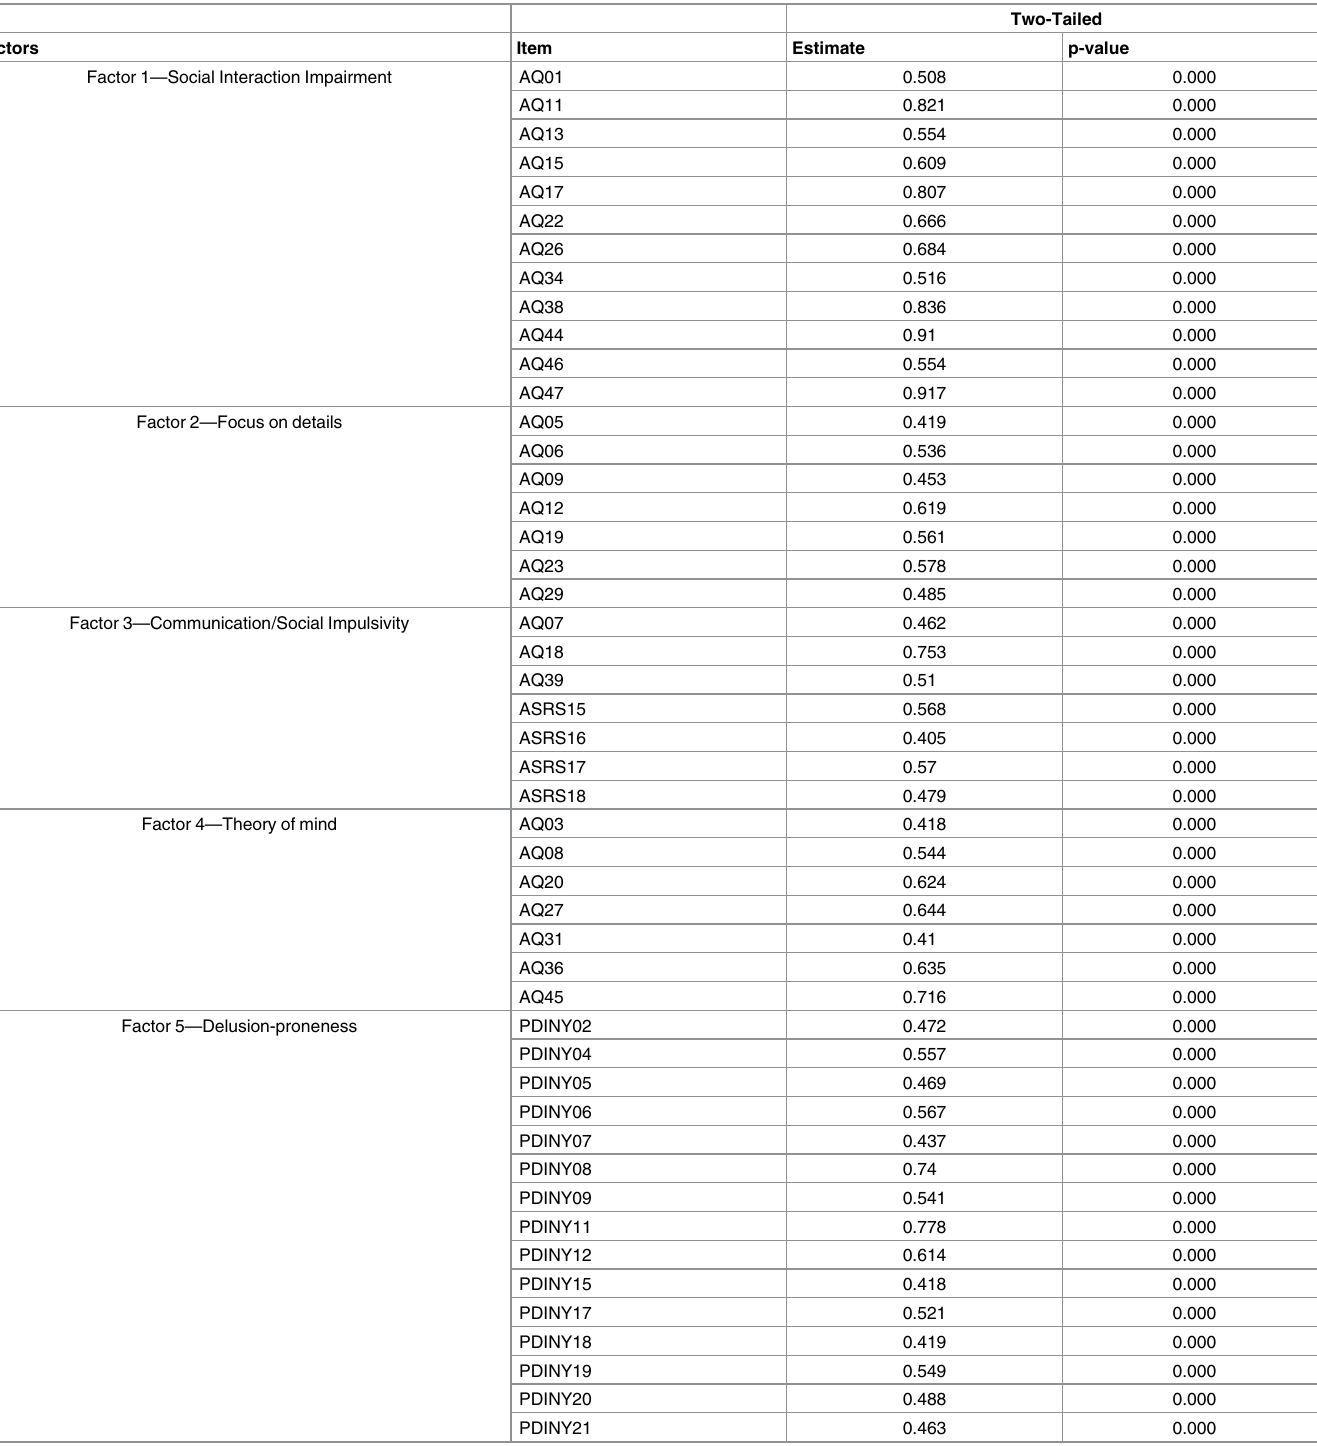
Table 2. 7-factor model (full